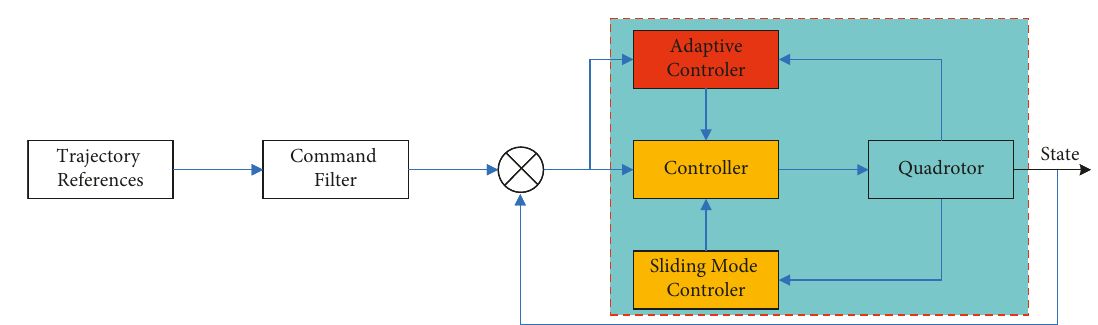
Figure 2: Sigma-Pi neural network structure.